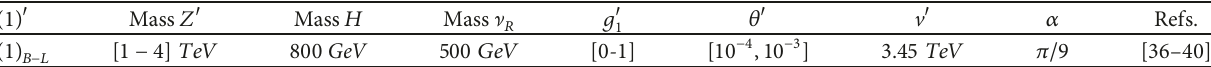
Table 2: Benchmark model parameters.